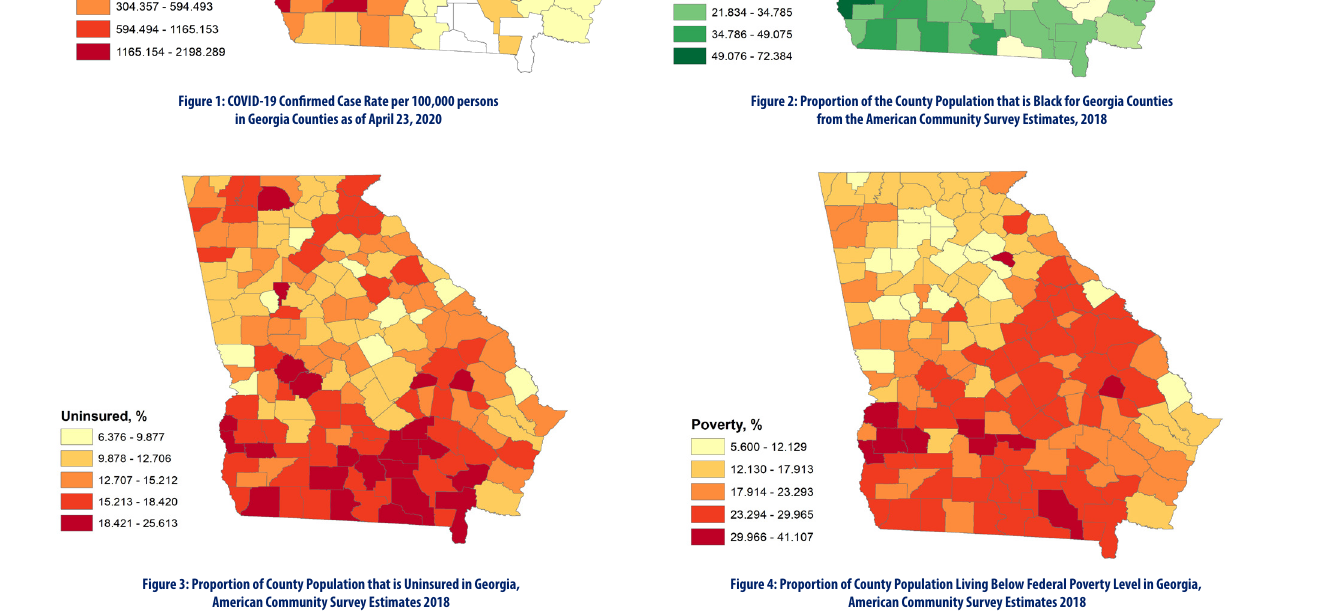
Figure 4: Proportion of County Population Living Below Federal Poverty Level in Georgia, American Community Survey Estimates 2018